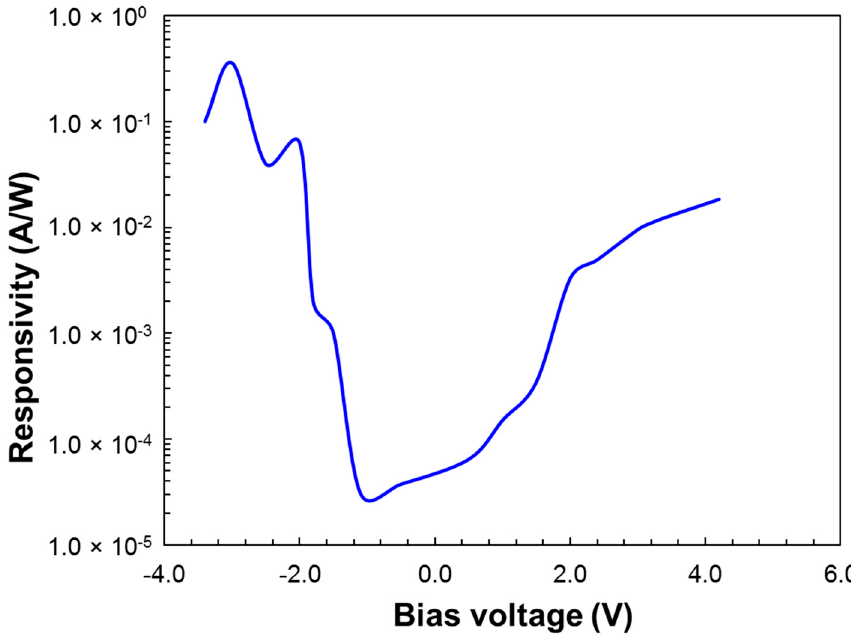
Figure 6. Photoresponsivity ℜ of the dual-band QDIP under different bias voltages.